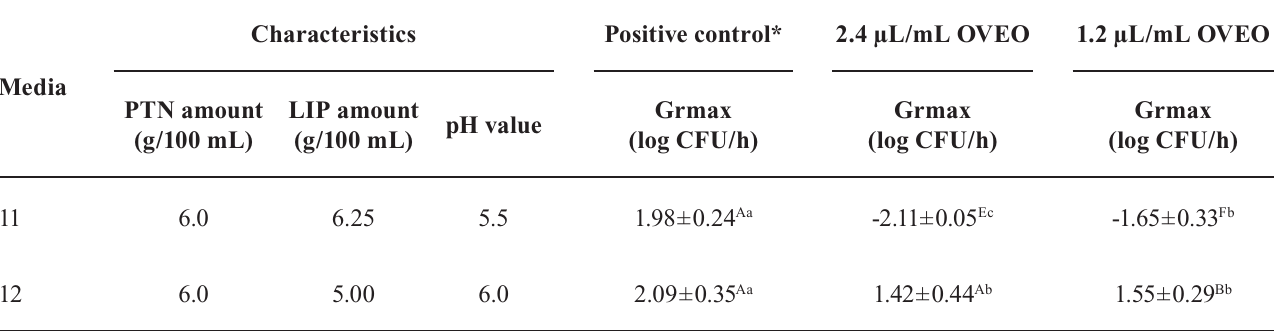
TABLE II - Maximum specific growth rate (Grmax, log CFU/h) estimates for Escherichia coli UFPEDA 224 in media with different amounts of proteins, lipids and pH values and 2.4 or 1.2 µL/mL Origanum vulgare L. essential oil (OVEO). Results of Grmax values are expressed as the average ± standard deviation (n=9). Grmax values were measured by EON-Gen5 software (EON, BioTek, USA) considering the results of absorbance based microtiter plate assay